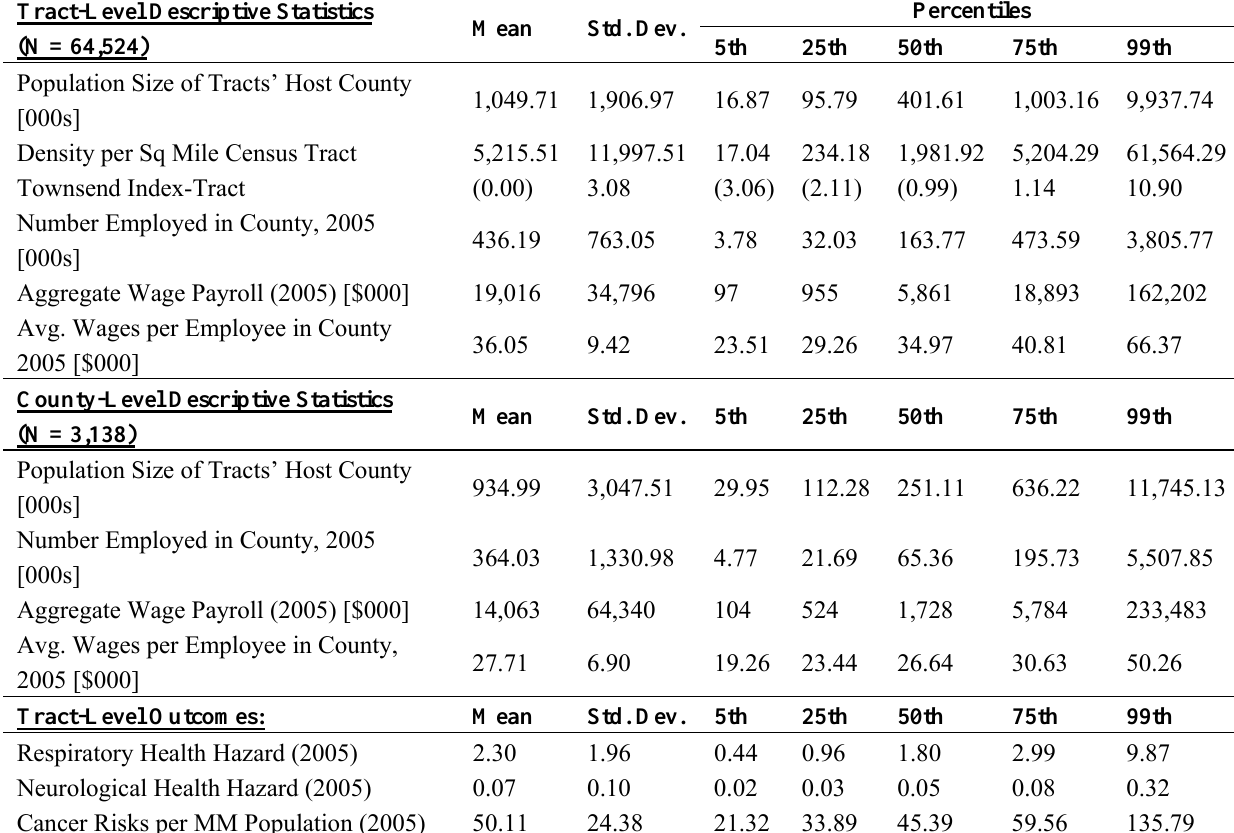
Table 1. Descriptive Statistics for Study Variables: Tracts &